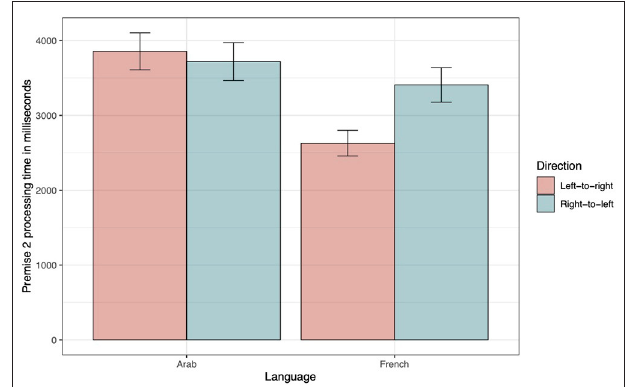
FIGURE 6 | Premise 2 processing time as a function of Direction and Language. The within-subjects 95% confidence intervals were computed following the method proposed by Morey (2008) and were implemented using the R functions developed by Chang